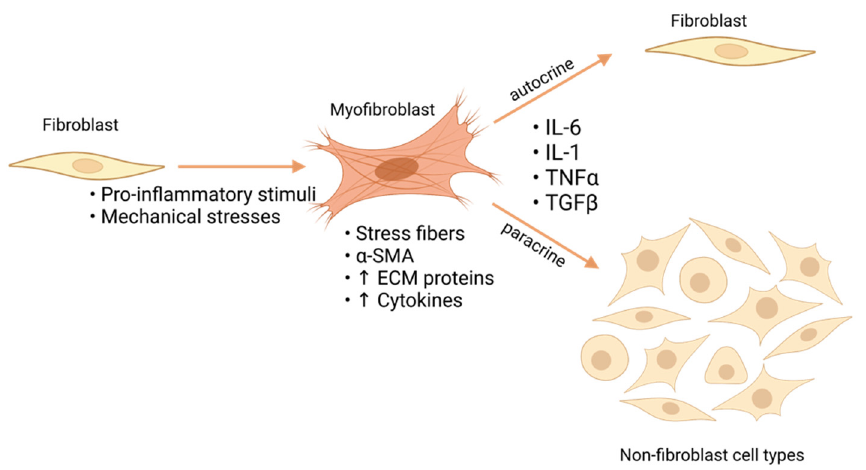
Figure 1. Fibroblasts activation mechanism. Pro-inflammatory signaling and mechanical stress after cardiac injury promote the activation of fibroblasts into myofibroblasts. Myofibroblasts, characterized by actin stress fibers, α -SMA, increased cytokines (TGF- β , IL-6, IL-1, TNF α ), and ECM protein secretion, are responsible for both paracrine and autocrine effects on adjacent cells. α -smooth muscle actin ( α -SMA); Transforming growth factor β (TGF- β ); Interleukins (IL-6, IL-1); tumor necrosis factor α (TNF α ); extracellular matrix (ECM). Created with Biorender.com (accessed on 15 June 2022).